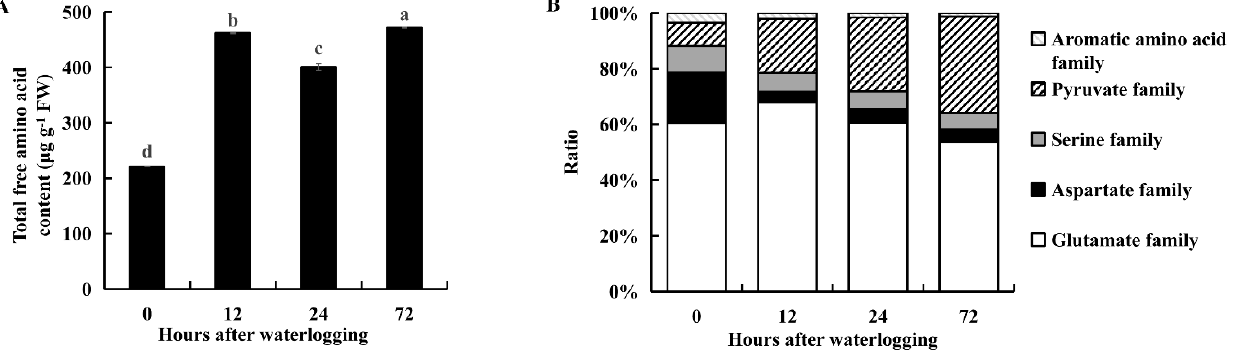
Figure 7. Changes of the total free amino acid content ( A ) and the proportion of different amino acid family ( B ) in KR5 roots under waterlogging stress. In ( A ) the total free amino acid content was estimated as the sum of the contents of 16 individual free amino acids. Data are expressed as averages ± SD, n = 3. Significant differences between treatments at p < 0.05 are indicated by different letters over columns (Duncan’s test).